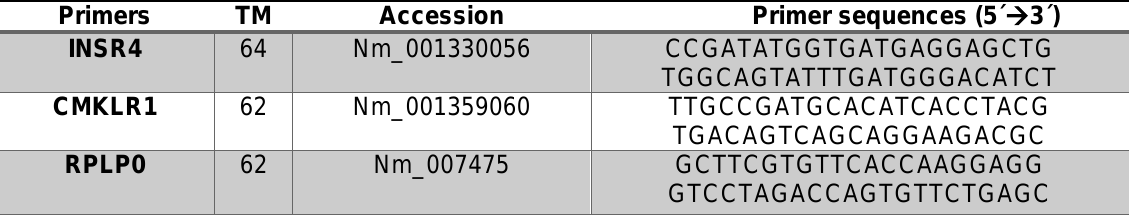
Table 1: Primer sequences used for real-time